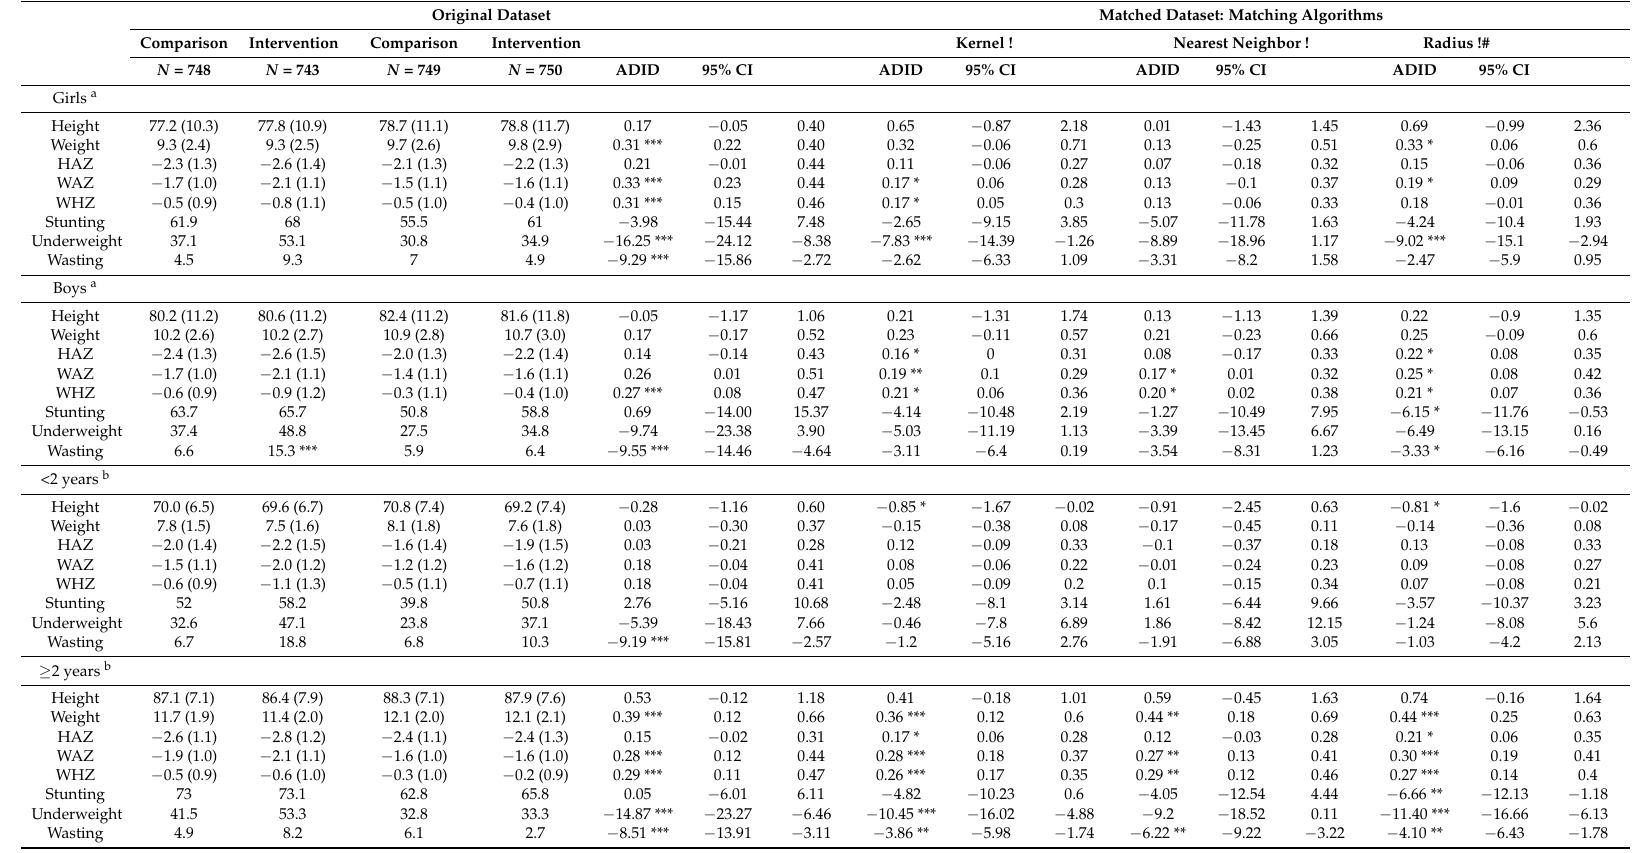
Table 4. Program impact on child